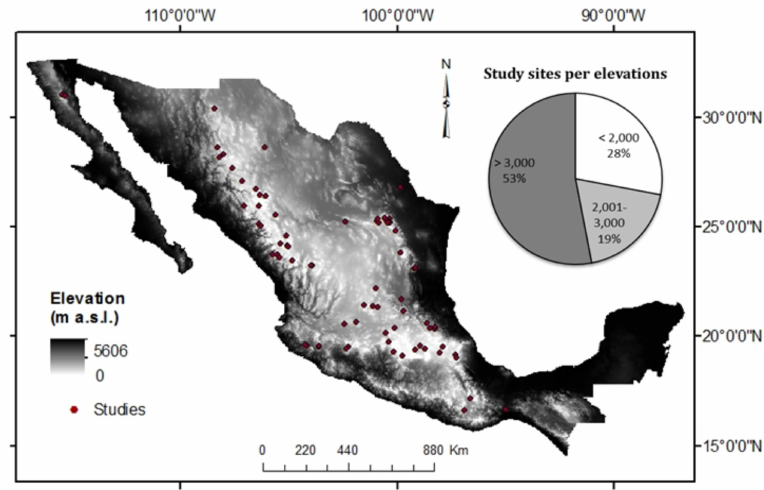
Figure 1. Sample sites of the dendrochronological studies carried out in Mexico. The upper right graph indicates the classification of sites based on their elevation.